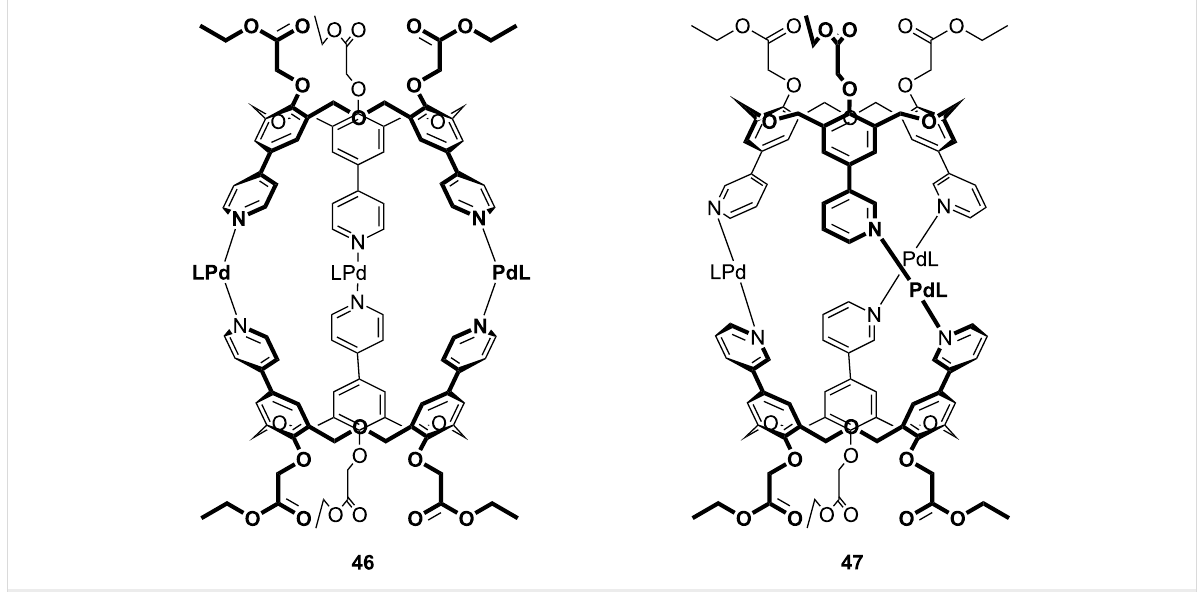
Figure 14: Oxacalix[3]arene capsules 46 and 47 formed through coordination chemistry [52,53].